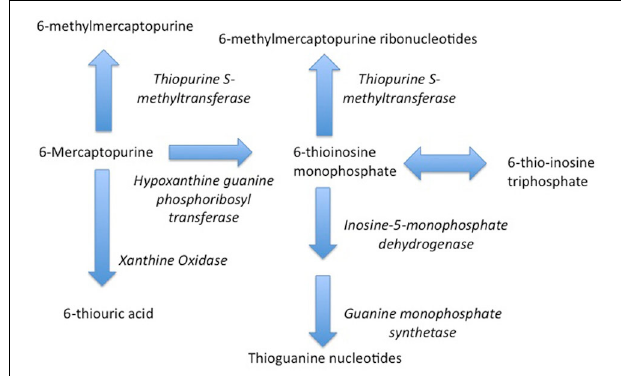
FIGURE 1 | Metabolism of 6-Mercaptopurine (6-MP). Metabolism of 6-MP via Hypoxanthine-guanine Phosphoribosyltransferase produces active Thioguanine nucleotide analogues while metabolism of 6-MP by Thiopurine Methyltransferase produces inactive 6-methylmercaptopurine. Genetically determined variations in 6-MP metabolism can produce significant differences in efficacy and